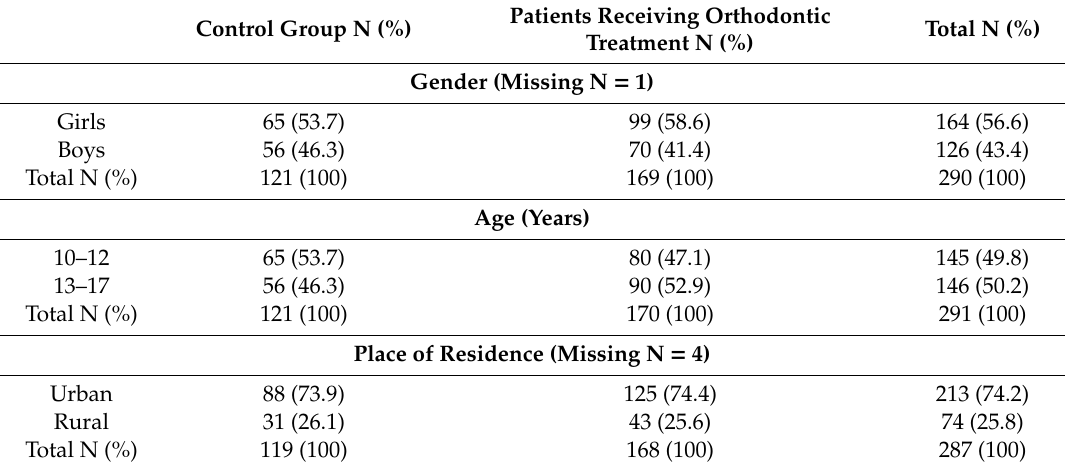
Table 1. Demographic characteristics of